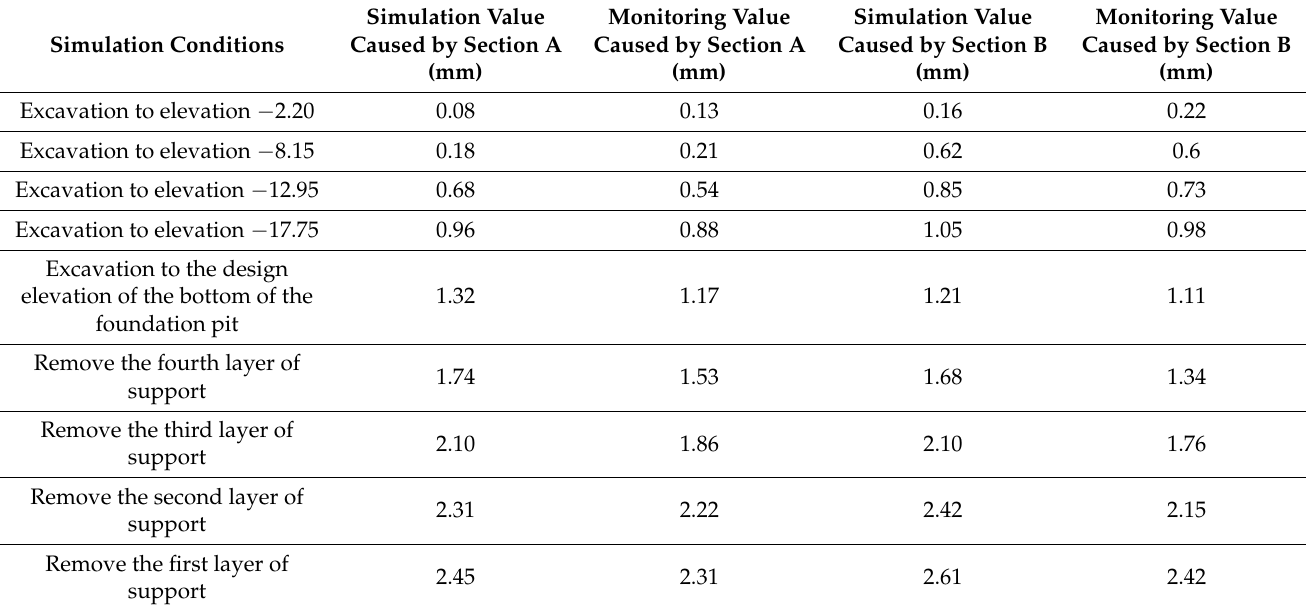
Table 4. Maximum vertical deformation of subway tunnel caused by pit